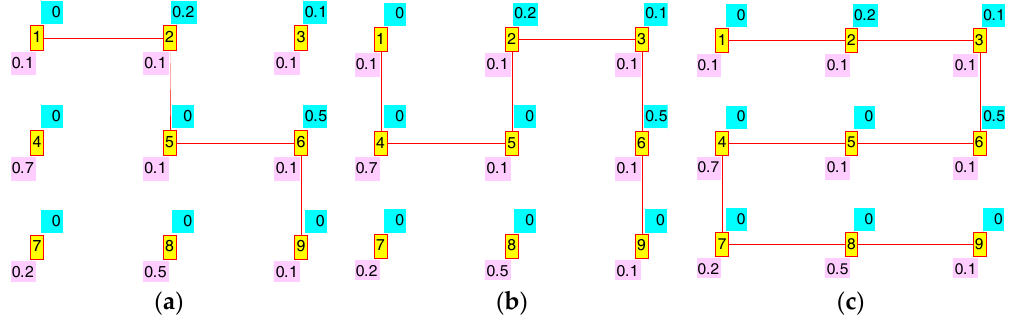
Figure 8. ( a ) S(t) = 1, R(t) = 0.1; ( b ) S(t) = 0.5, R(t) = 0; ( c ) S(t) = 0, R(t) = 0.